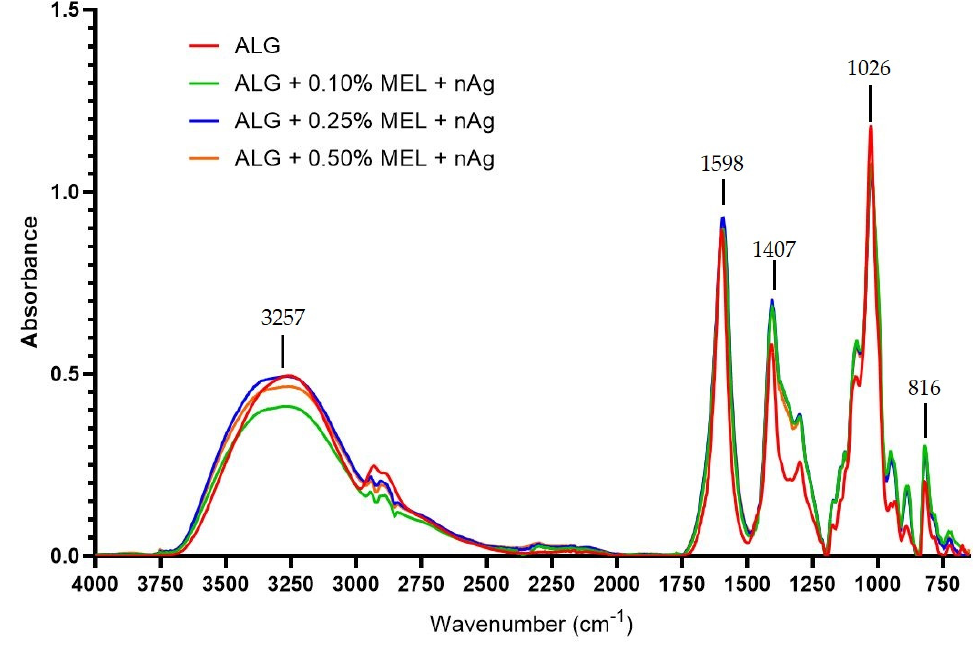
Figure 8. FT-IR spectra of unmodified and modified with melanin and silver nanoparticles alginate films.